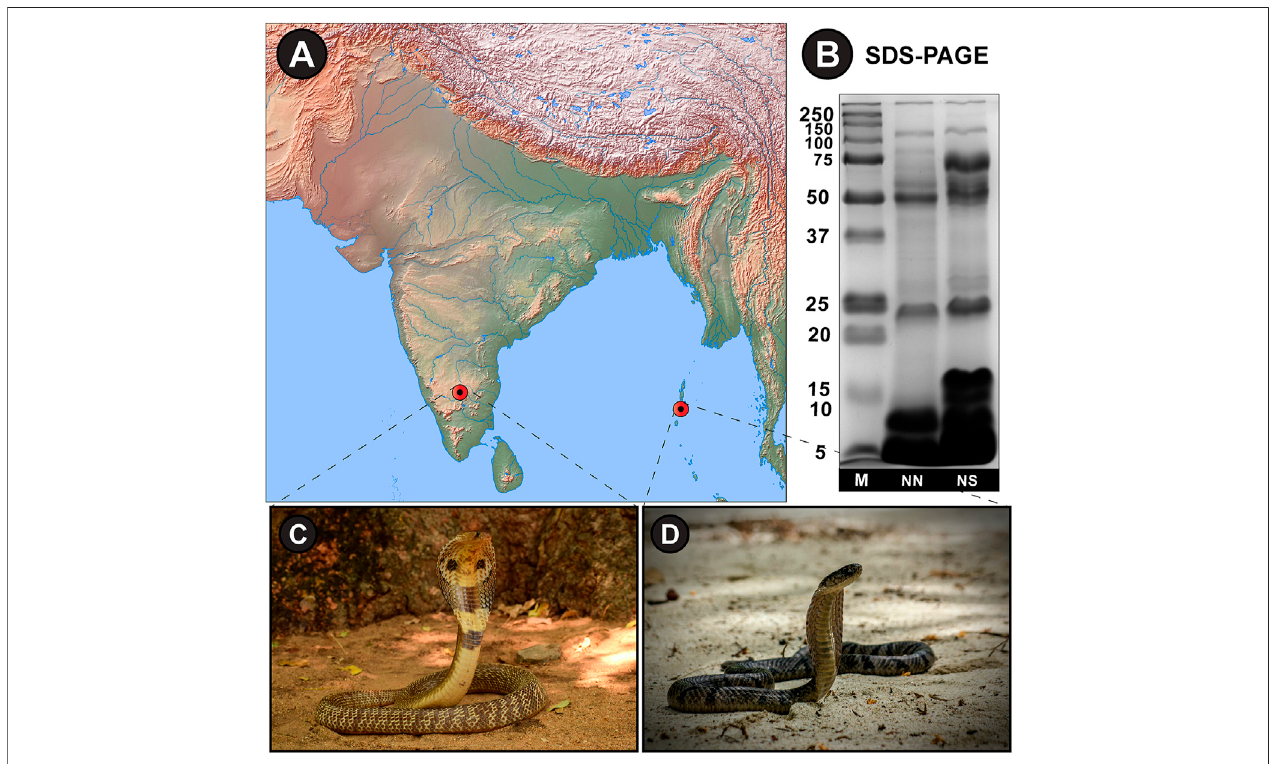
FIGURE 2 | (A) Sampling locations from mainland India and Andaman and Nicobar Islands have been shown on a map of India prepared using (QGIS, 2019). (B) SDS-PAGE venom pro fi les and photographs of (C) N. naja and (D) N. sagittifera . M: Protein marker (units in kDa); NN: N. naja ; NS: N. sagittifera .